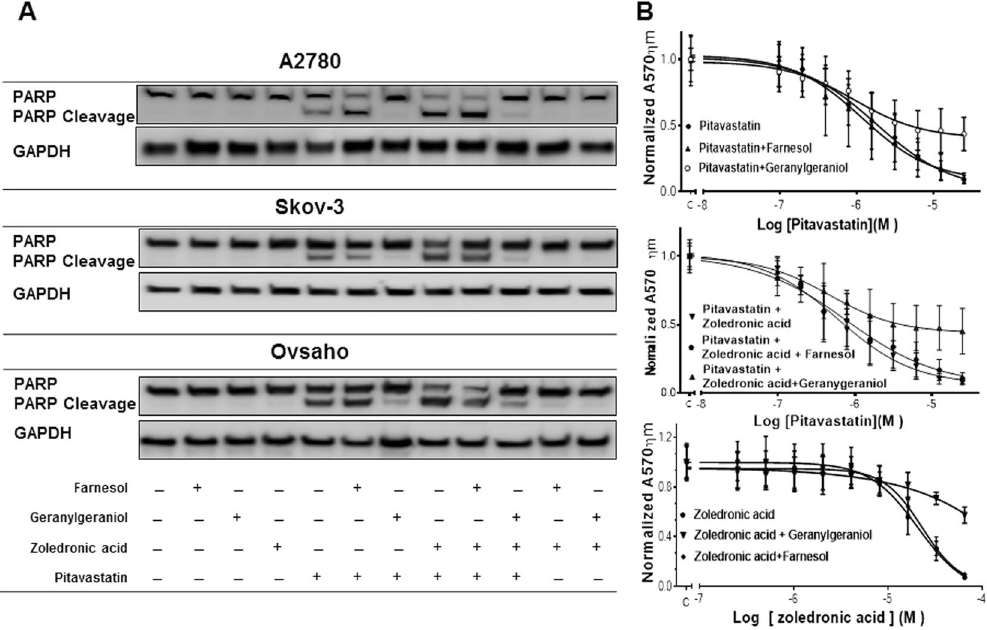
Figure 4. The effect of the pitavastatin-zoledronic acid drug combination is blocked by geranylgeraniol. ( A ) Cells treated with pitavastatin (A2780 and Ovsaho 1 µ M and Skov-3 5 µ M) and farnesol (10 µ M) geranylgeraniol (10 µ M) zoledronic acid (10 µ M) for 48 hrs. PARP cleavage was assessed by immunoblotting. The results are representative of 3 experiments. ( B ) Skov-3 cell line was treated with pitavastatin or pitavastatin and zoledronic acid (10 µ M) and geranylgeraniol (10 µ M) and farnesol (10 µ M) and after 72 hrs relative cell number was determined by staining with SRB. ( C ) morphological changes of Skov-3 cell line treated with indicated drug concentration for 72 hr were visualized by phase - contrast light